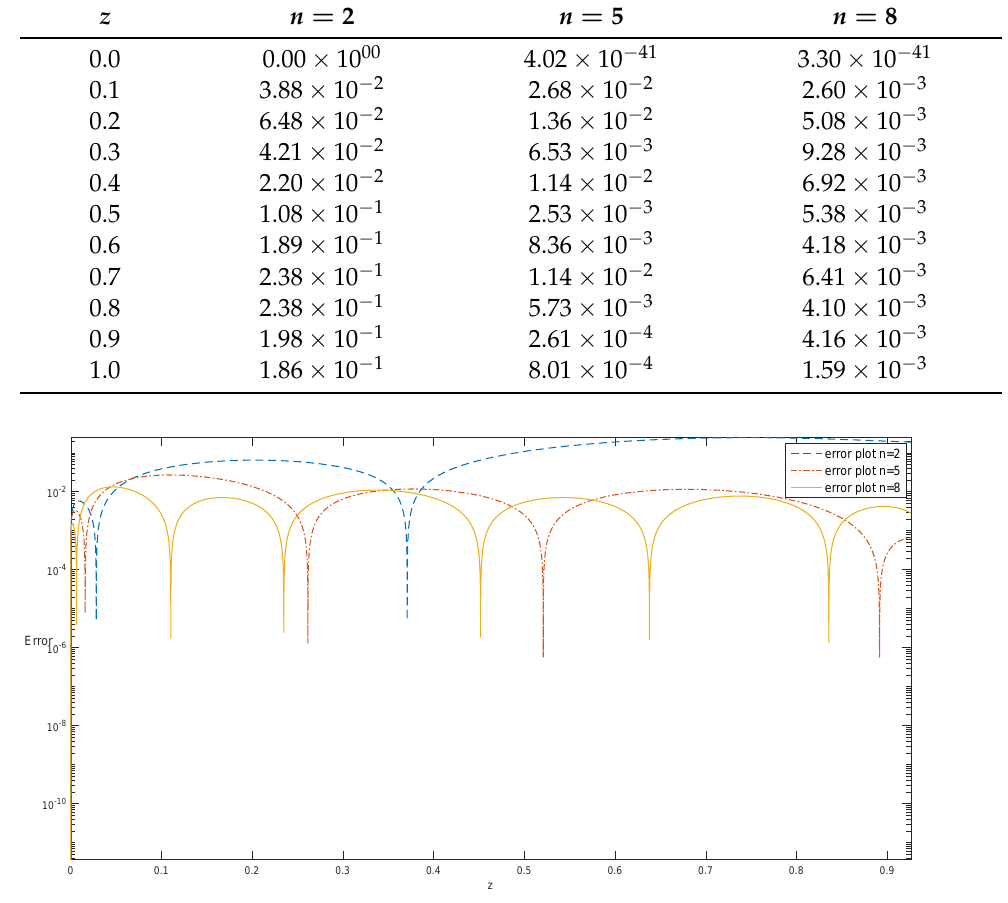
Table 7. Absolute error for α = 0.85 and n = 2, 5 and 8 in Example 4.